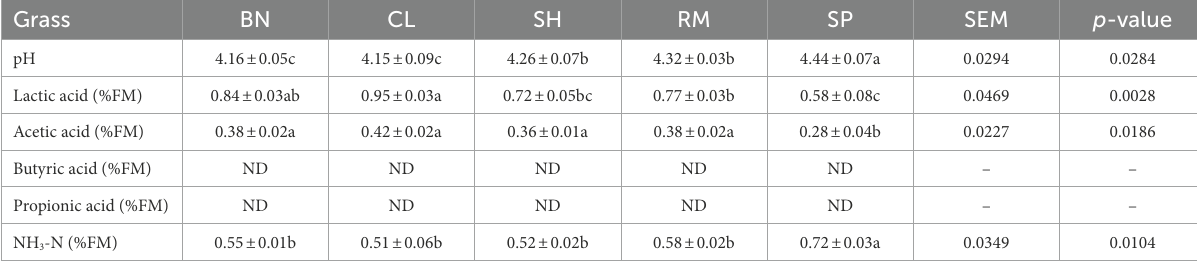
TABLE 2 Fermentation quality of native